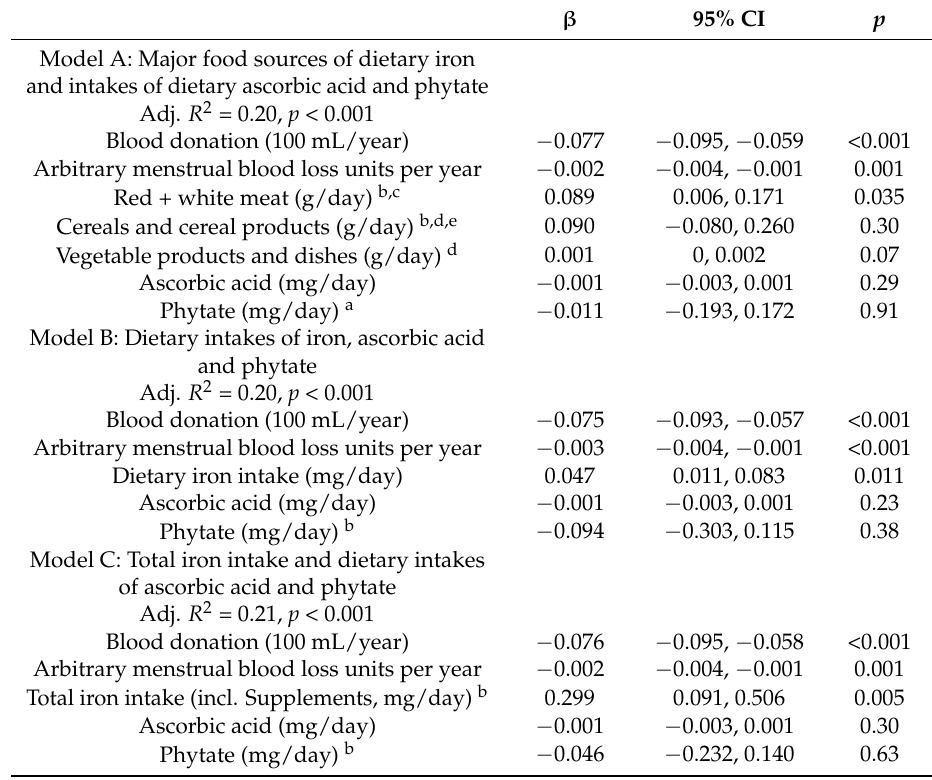
Table 3. Multivariate models of determinants of serum ferritin concentration in women aged 18–50 years ( n = 313) a,b .